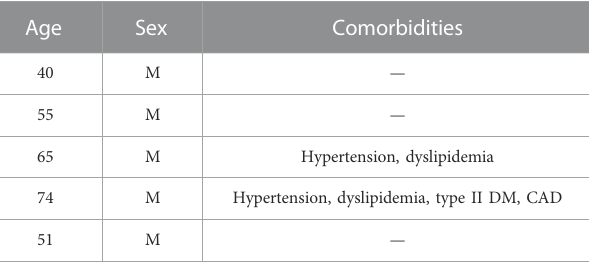
TABLE 1 Demographics and comorbidities of NP tissue